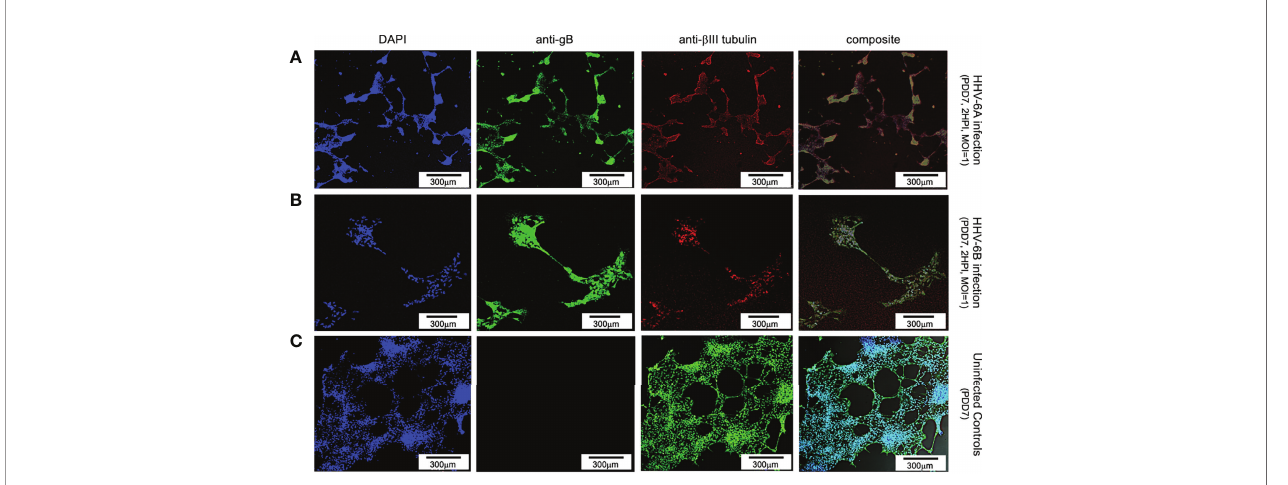
FIGURE 2 | Fluorescence microscopy images of dHNSCs treated with immuno fl uorescent antibodies and a fl uoro-dye at PDD7: Differentiation to neurons. From left to right, DAPI, anti-gB, anti-bIII tubulin, and composites. PDD7 dHNSC infected with HHV-6A (row A ) show gB-positive signal on bIII tubulin-positive cells. PDD7 HNSC infected with HHV-6B (row B ) also show gB-positive signal on bIII tubulinpositive cells. Images for uninfected control culture (row C ) show developed bIII tubulin-positive cells with signi fi cant neurite-neurite and neurite-soma connectivity. [Scale bar = 300